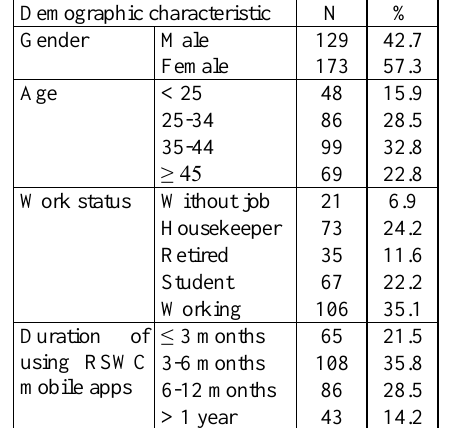
Figure 2. Research